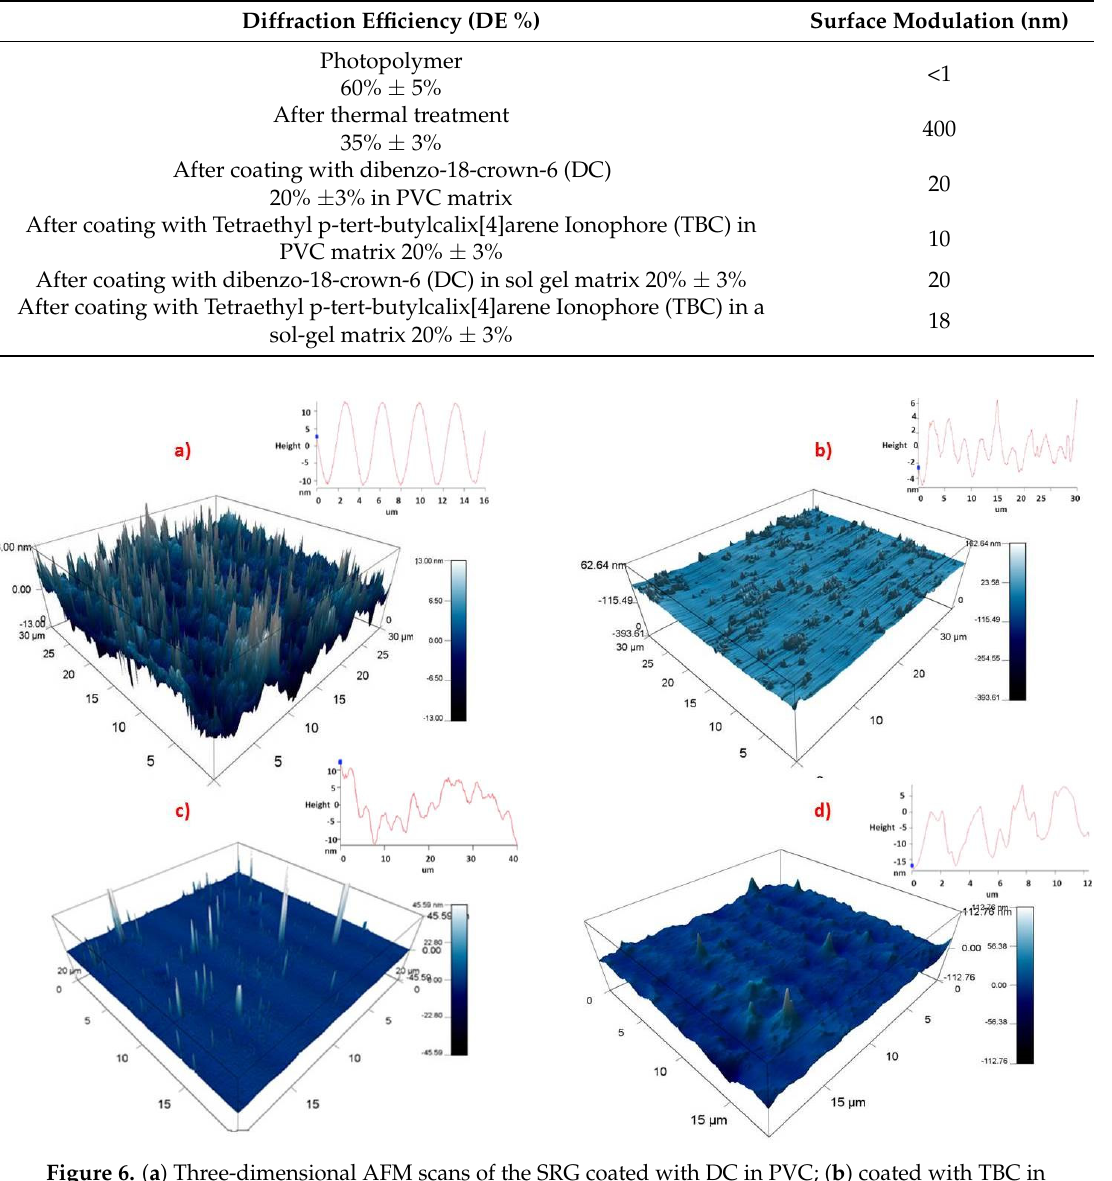
Figure 6. ( a ) Three-dimensional AFM scans of the SRG coated with DC in PVC; ( b ) coated with TBC in PVC; ( c ) coated with DC in a sol-gel matrix; ( d ) coated with TBC in a sol-gel matrix.